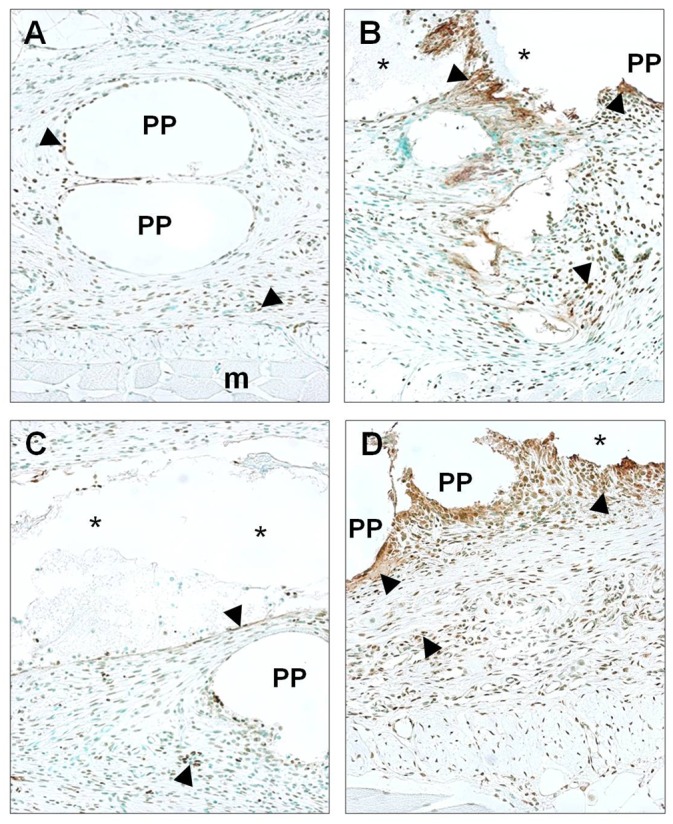
Cell damage.TUNEL-positive cells (►) in abdominal wall implanted with reticular PP mesh (Surgipro) fixed with sutures (control group) and with the different CAs (Glubran, Ifabond and OCA) 14 days after implantation. (A) Sutures, control group (200x). (B) Glubran (200x). (C) Ifabond (200x). (D) OCA (200x). (*: Tissue Adhesive; PP: polypropylene filaments; m: muscle).